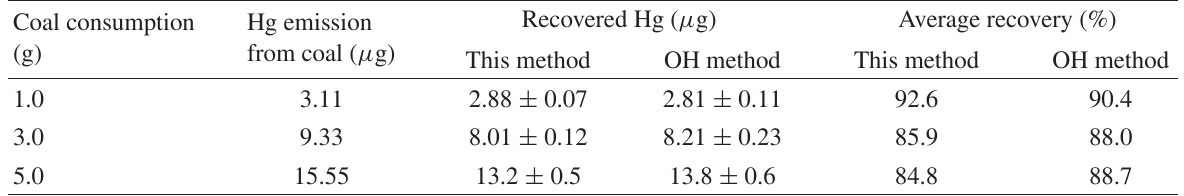
TABLE 5: Comparison of Hg measurements in flue gas between the new sorbent method and OH method in lab ( n = 3 ).